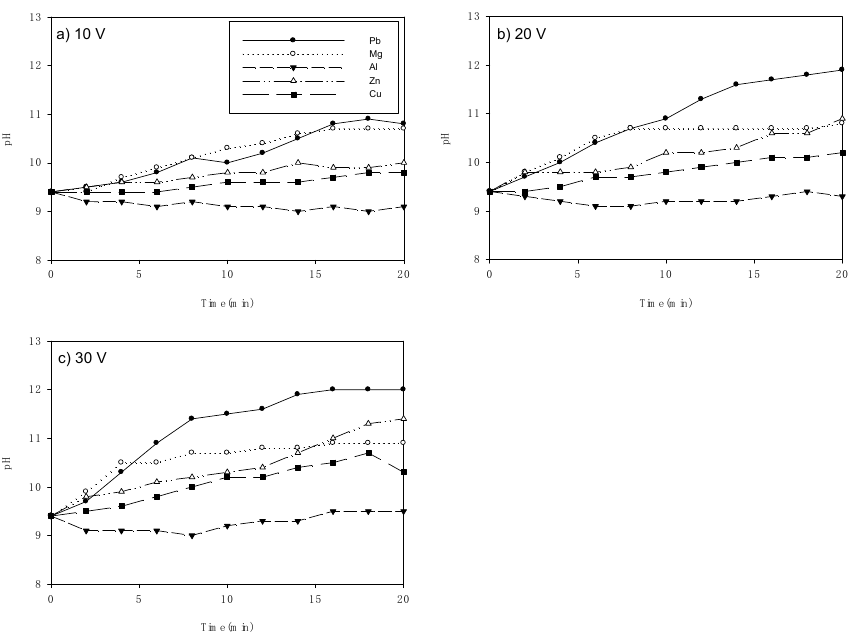
Figure 8. Effect of voltage and electrode material on the pH of the supernatant during electrocoagulation at ( a ) 10 V, ( b ) 20 V, and ( c ) 30 V.